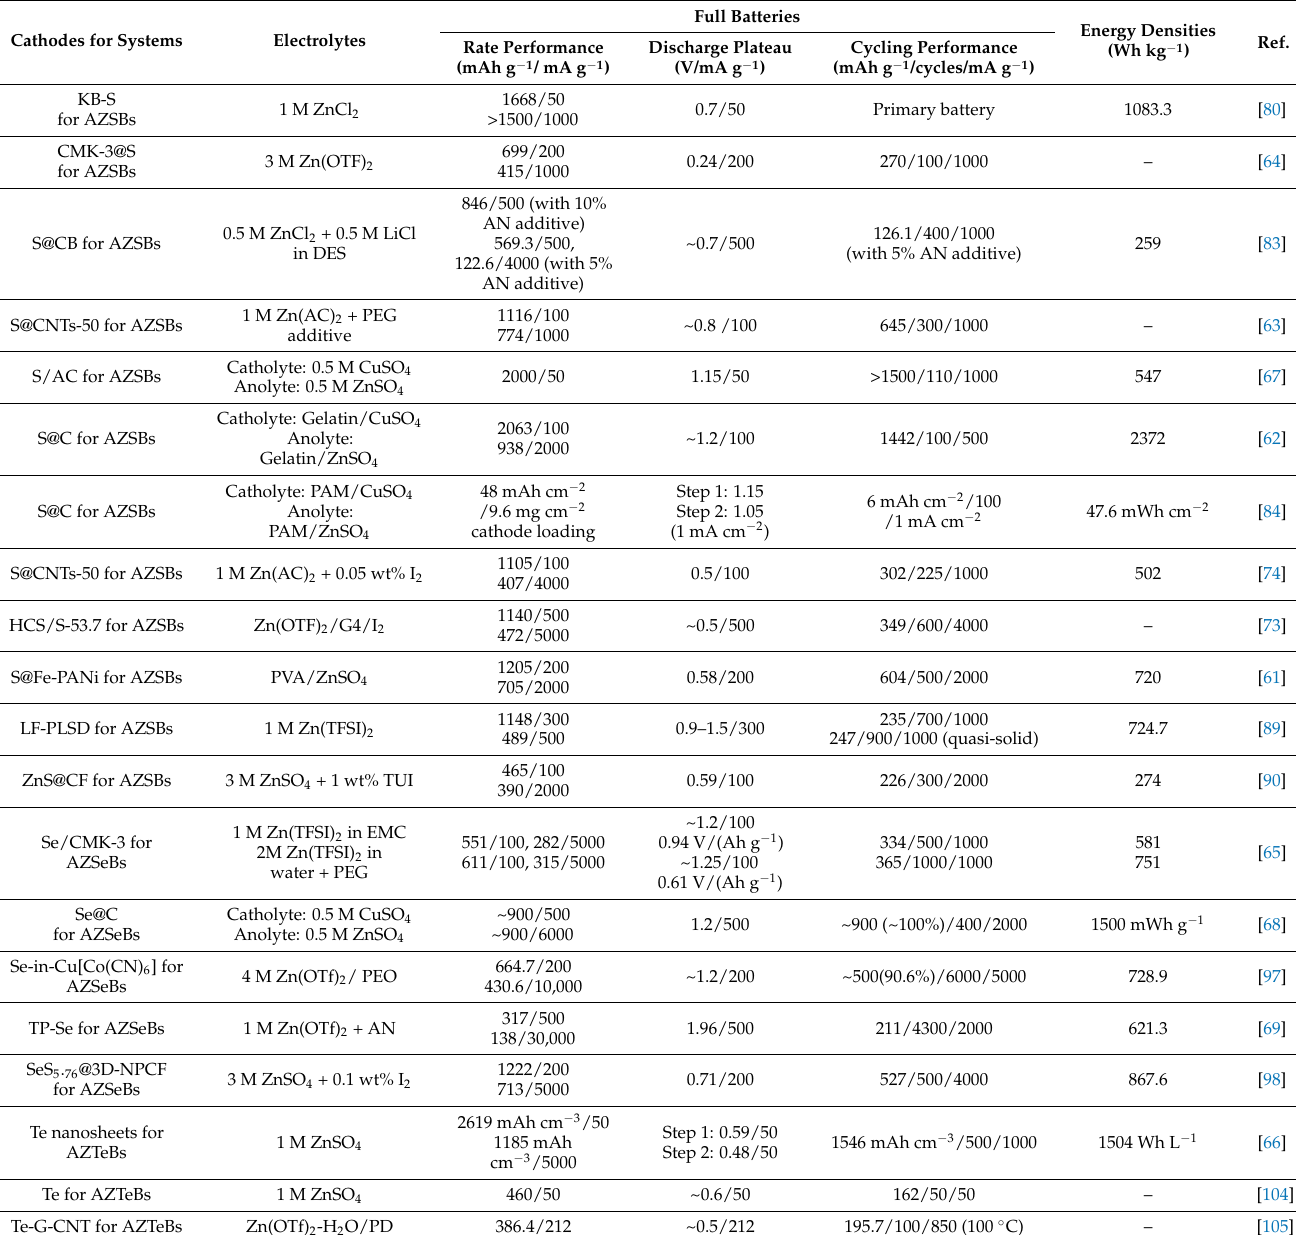
Table 1. Comprehensive comparison of electrochemical properties among the typical